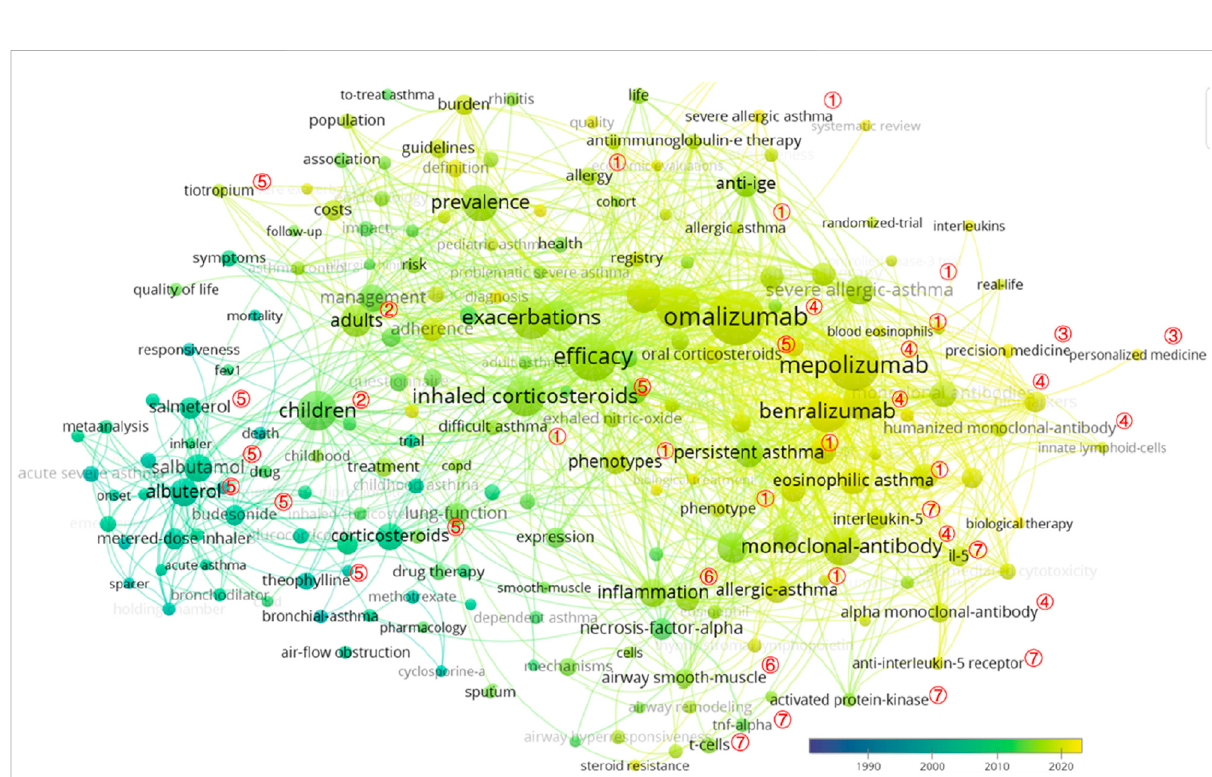
FIGURE 7 VOSviewer network map of co-occurrence analysis of all keywords in severe asthma. Notes: ① phenotypes: allergic asthma; eosinophilic asthma, persistent asthma, and dif fi cult asthma; ② populations: children and adults; ③ precision treatment: precision medicine and